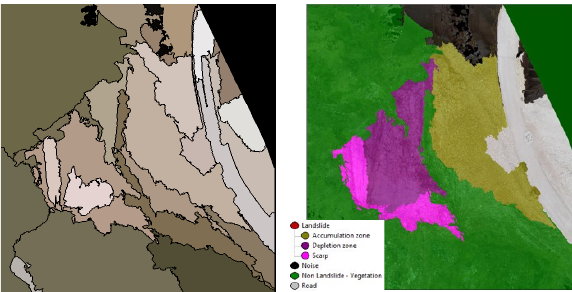
Figure 7. Final segmentation (left) and classification (right) result in object-based approach